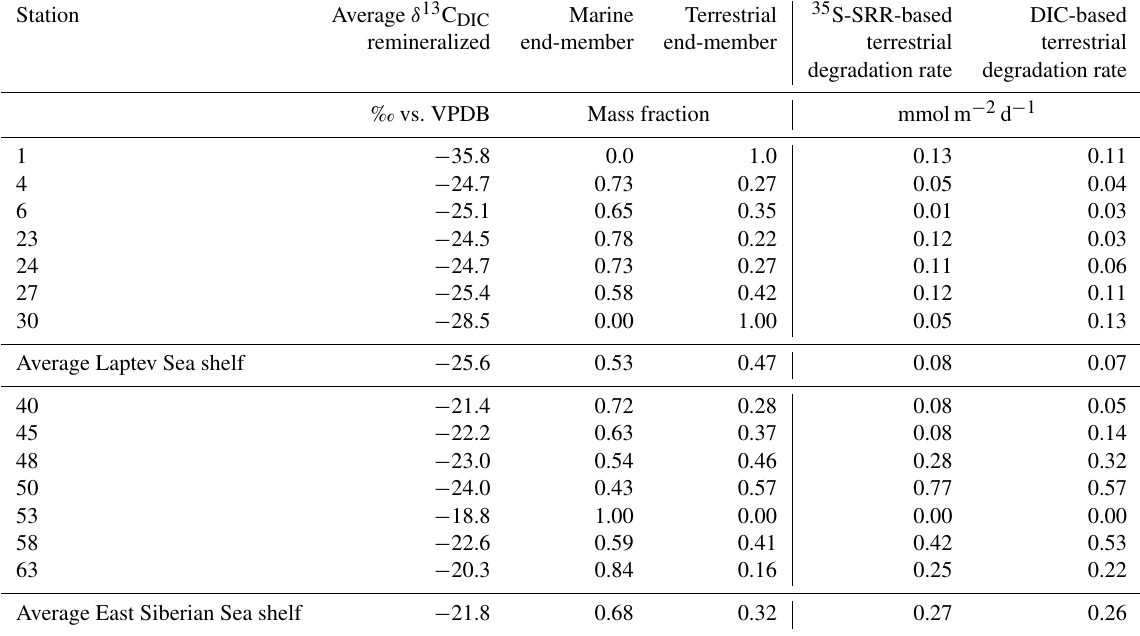
Table 4. Calculated carbon isotope composition of remineralized DIC and mass fractions of the marine and terrestrial end-members and corresponding terrestrial carbon degradation rates based on 35 S-SRR and DIC flux. Station Average δ 13 C